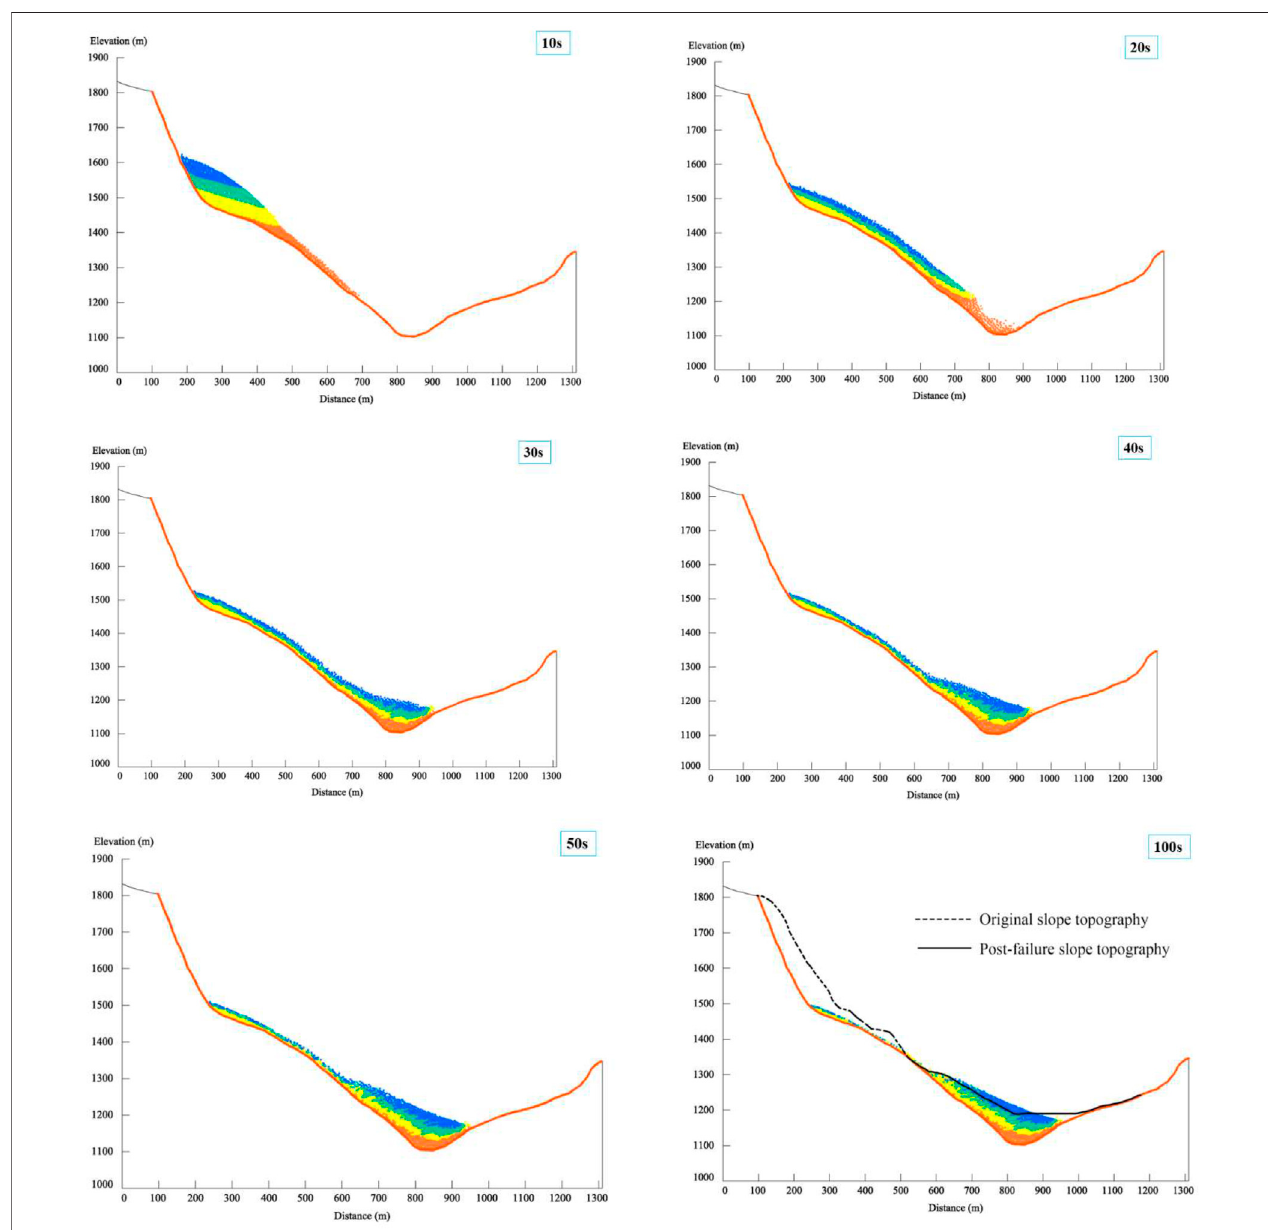
FIGURE 11 | Evolution of the landslide ’ s movement and